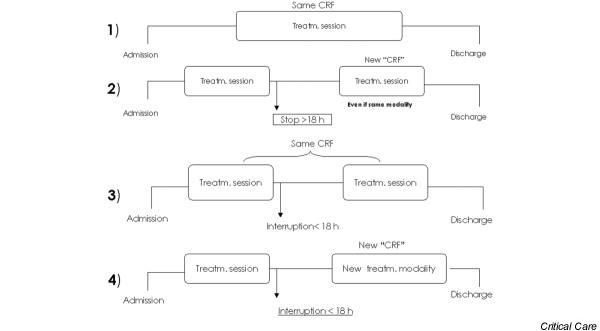
Examples of how the different case report forms will be applied. Four different cases are summarized, encompassing treatment interruption or end in relation to the compilation of case report forms (CRFs). Case 1 is the easiest case. The patient is admitted to the intensive care unit (ICU), is treated with renal replacement therapy (RRT), ends treatment and is discharged. The patient has a single CRF. In case 2 the patient is admitted and is treated with RRT, but this treatment is stopped for longer than 18 hours (this is defined as treatment end). However, the patient is later started on RRT again. A new CRF (even if the modality is the same) will need to be completed. In this case, the patient has two or more CRFs (as in the case of more than one treatment stoppages for longer than 18 hours). In case 3 the patient is admitted and is started on RRT, which is stopped for less than 18 hours (defined as interruption). The patient is then restarted and the compilation is continued on the same CRF. Case 4 is similar to case 3, with the important difference being related to the change in modality following treatment interruption. In this case, each change of modality will require a new CRF.